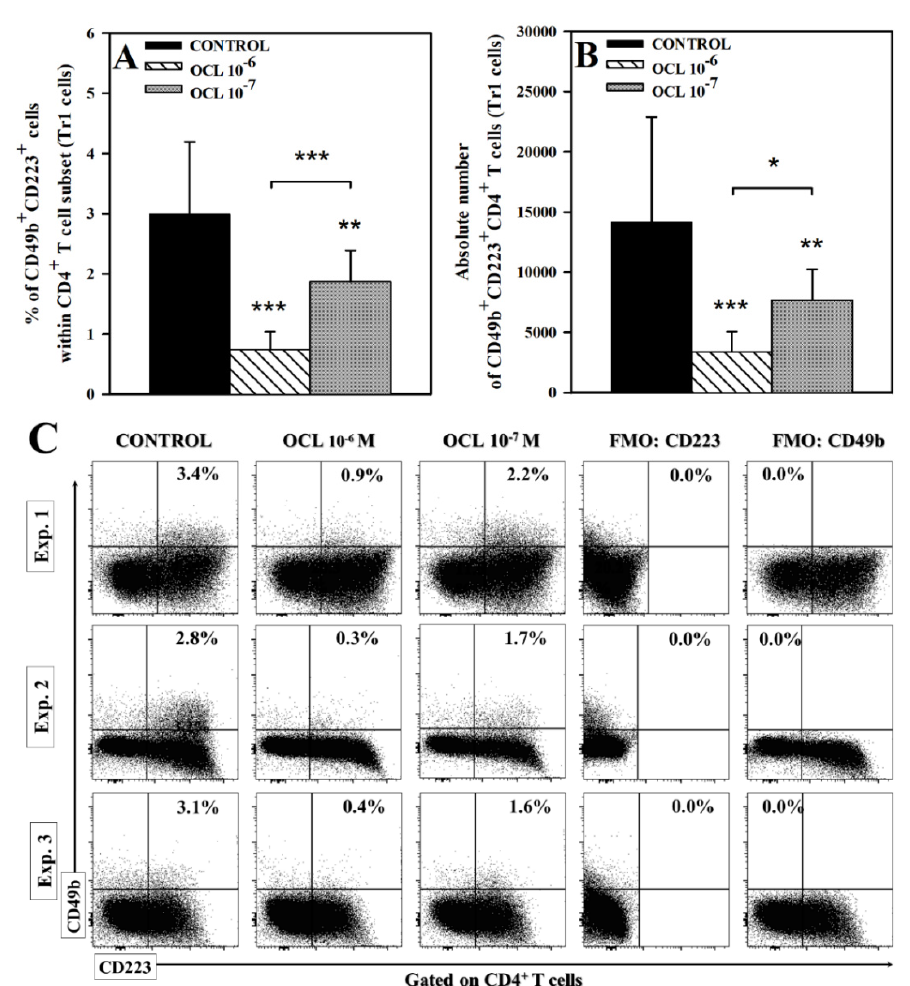
Figure 5. Effect of oclacitinib (OCL) on the number of CD49b + CD223 + CD4 + T cells. The relative ( A ) and absolute count ( B ) of CD49b + CD223 + CD4 + cells were determined in cell cultures incubated with or without (control) OCL (10 − 6 M and 10 − 7 M). The relative count is expressed as a percentage of CD49b + CD223 + cells within CD4 + T cell subset. The absolute count represents the number of CD49b + CD223 + CD4 + T cells per sample well. Cells with such a phenotype should be equated with Tr1 cells. Results are expressed as the mean (±S.D.) of three independent experiments with 5 mice per experiment (overall n = 15, * p < 0.05, ** p < 0.01, *** p < 0.001, control cells vs OCL-treated (10 − 6 or 10 − 7 M) cells (Student's unpaired t - test), or OCL 10 − 6 -treated vs OCL-10 − 7 -treated cells (one way ANOVA with Holm-Sidak multiple comparison test)). Examples of dot plot cytograms show the distribution of CD49b + CD223 + cells among CD4 + T cell subset ( C ). Fluorescence minus one (FMO) controls were applied to confirm the gating strategy used to identify CD49b + CD223 + cells.